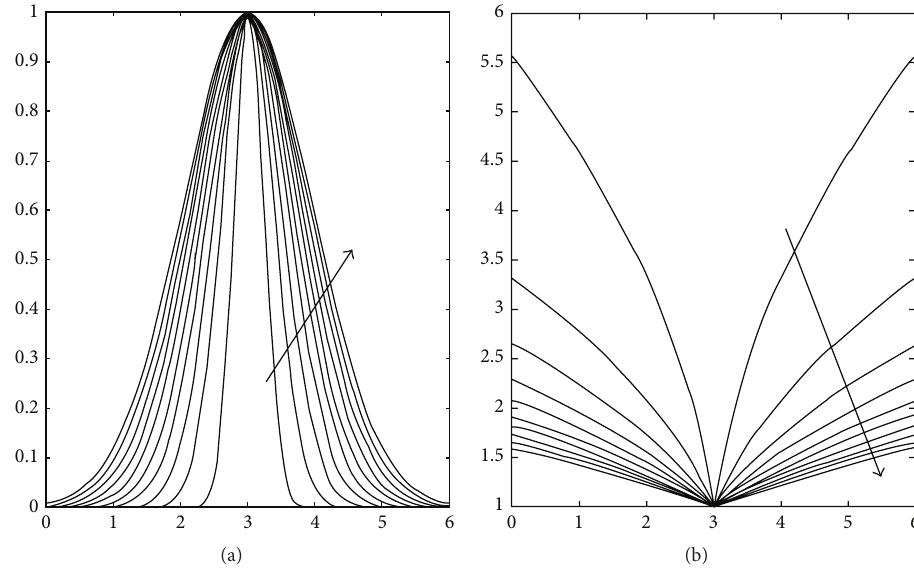
Figure 1: Shape change of the Gaussian (a) and multiquadric (b) basis with the increasing of the shape parameter 𝜎 𝑖 .